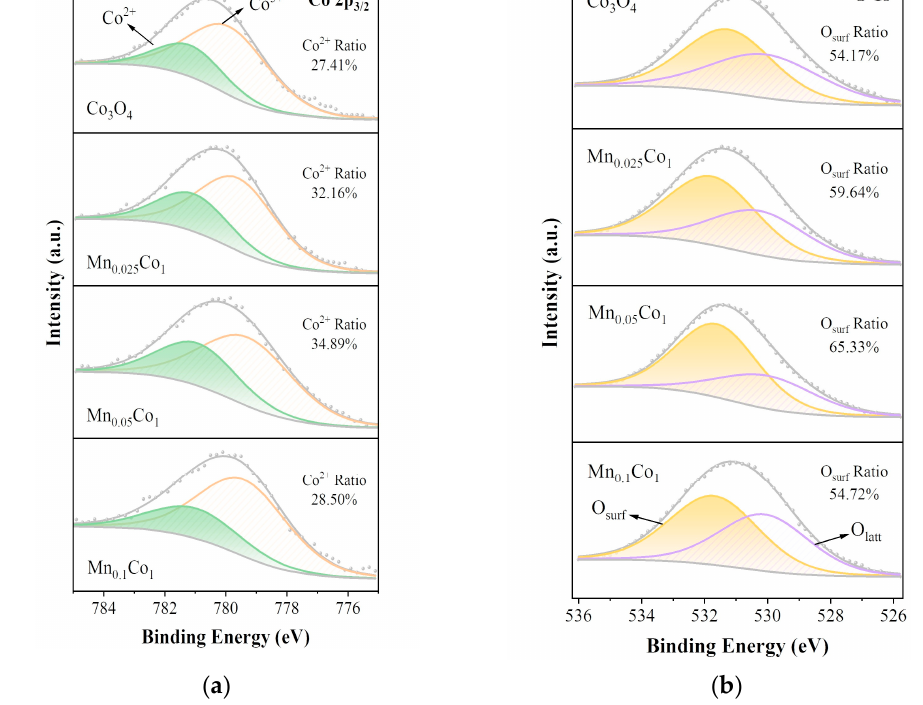
Figure 3. XPS spectra for ( a ) Co 2p 3/2 , ( b ) O 1s of Co 3 O 4 , Mn 0.025 Co 1 , Mn 0.05 Co 1 , and Mn 0.1 Co 1 catalysts.